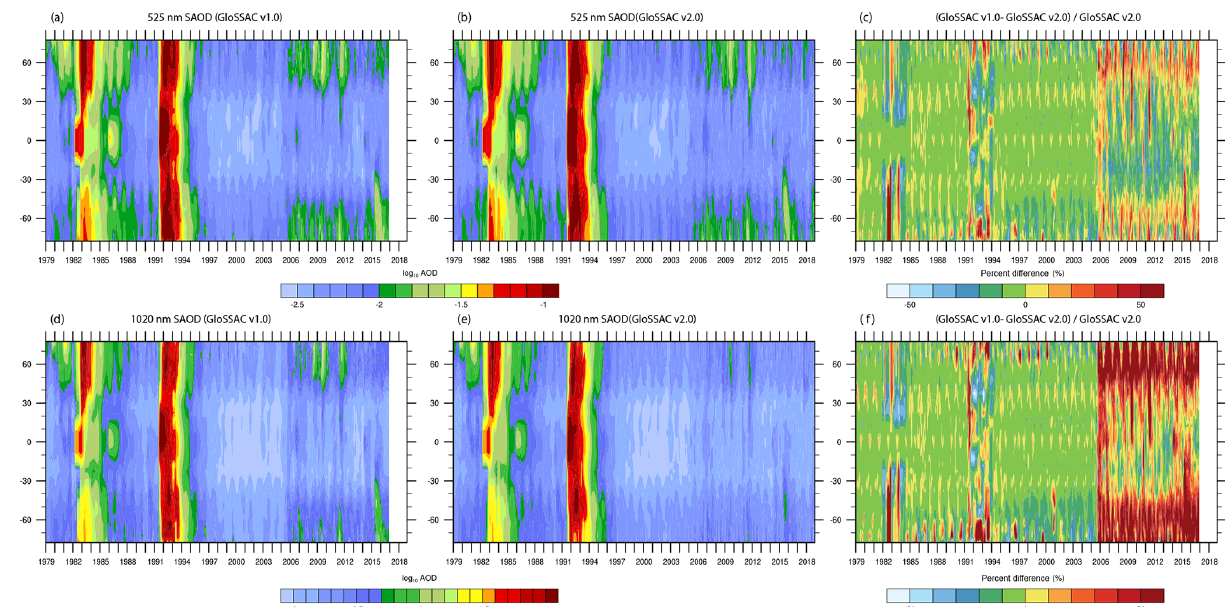
Figure 16. Same as in Fig. 15 but for GloSSAC v1.1 replaced by GloSSAC v1.0.